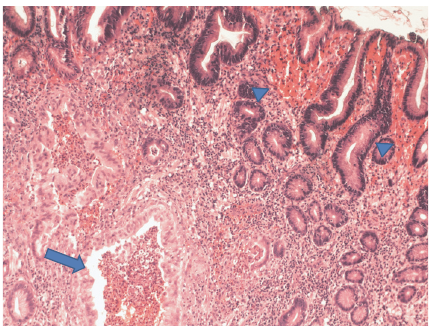
Figure 6: Haematoxylin and eosin (H&E) stain of gastric tissue at low power (100x magnification) demonstrating inflammatory poly- poid gastric mucosa, focal crypt abscesses, and increased chronic inflammation in the lamina propria, glandular epithelial reactive changes, and superficial foveolar epithelial regenerative